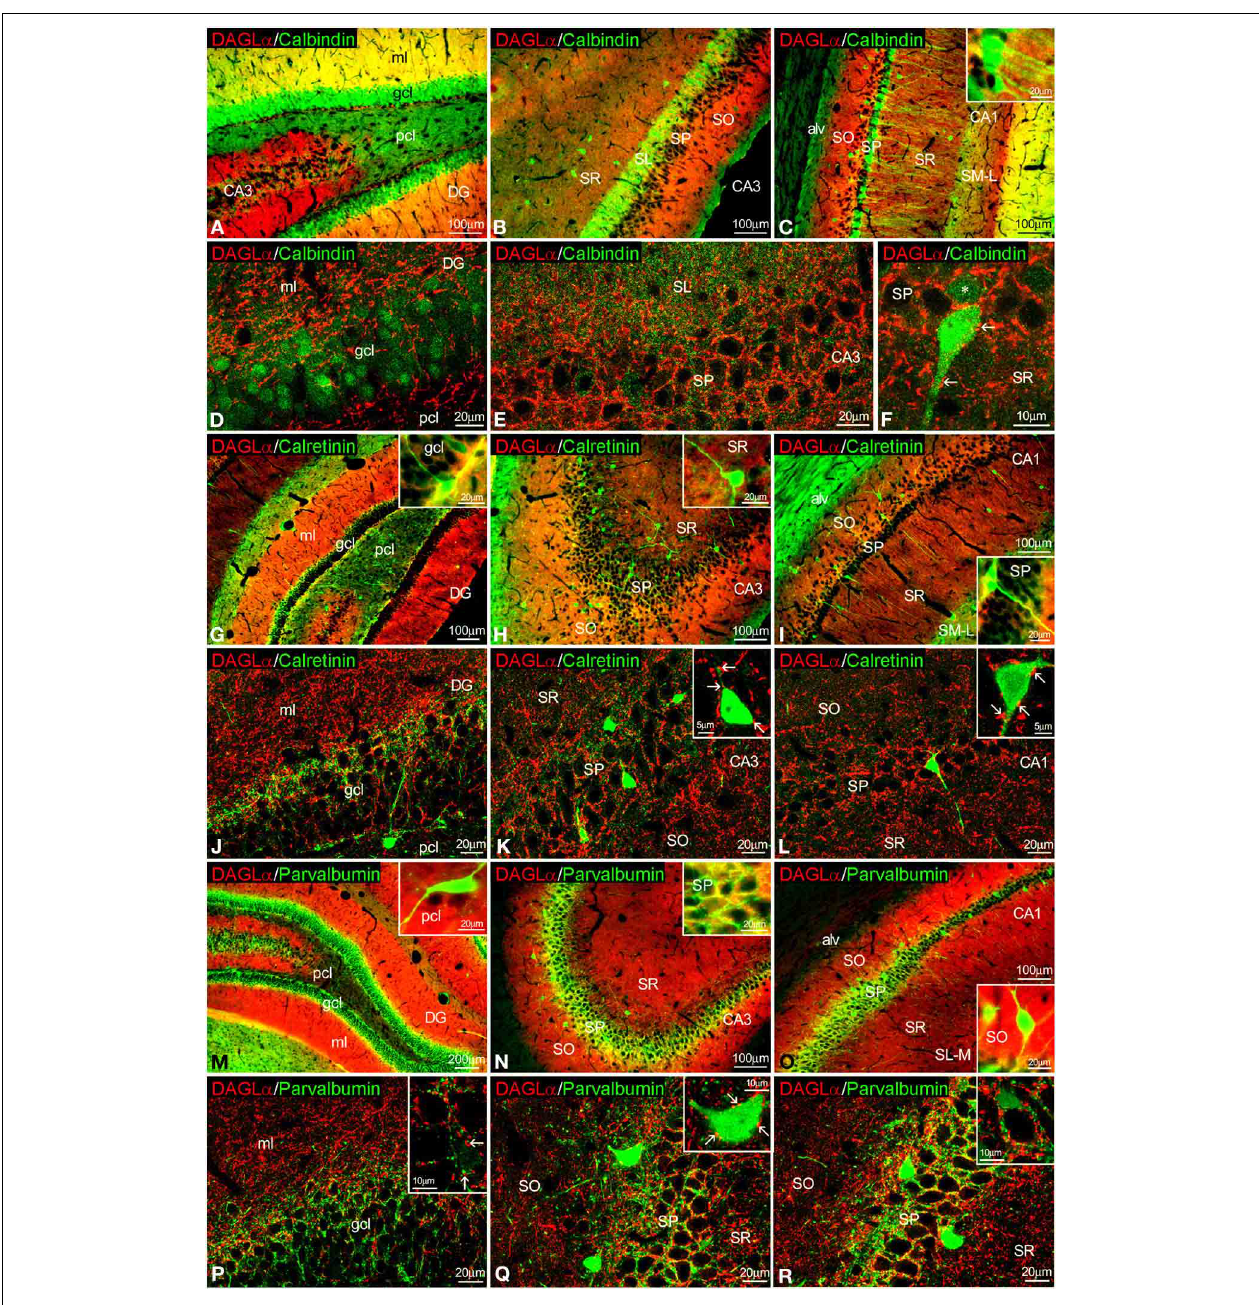
FIGURE 4 | Co-localization of DAGL α and calbindin, calretinin, or parvalbumin in the rat hippocampus. Low resolution epifluorescence photomicrographs (A–C,G–I,M–O) and high resolution confocal laser scanning photomicrographs (D–F,J–L,P–R) showing labeling for calbindin,